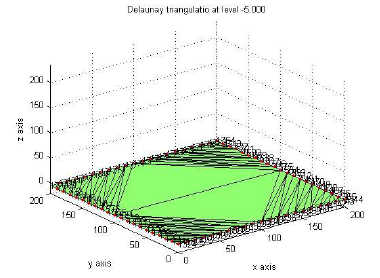
Figure25. Delaunay triangulation (level -5.000)